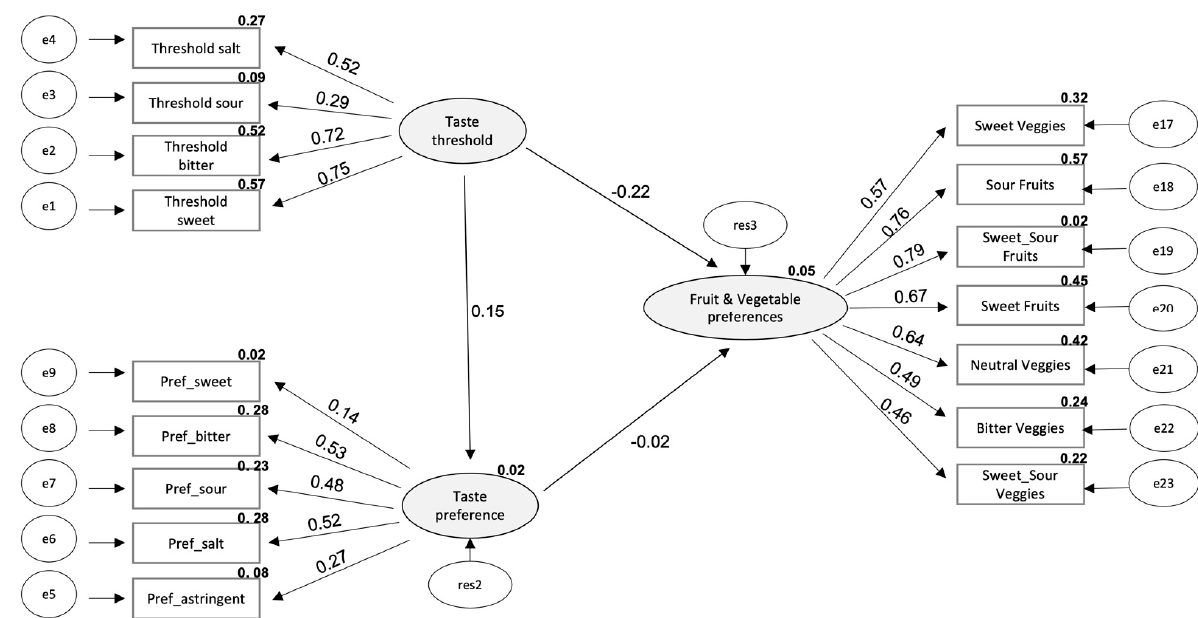
Figure 1. Structural equation model defined a priori to observe the relationship between taste threshold, taste preference, and fruit and vegetables preferences (Fruit & Vegetable preferences = − 0.22 × taste threshold − 0.02 × taste preference). Ellipses indicates latent unobservable constructs; box indicate observed variable; arrows indicate direct effects (e = error; res = residuals).